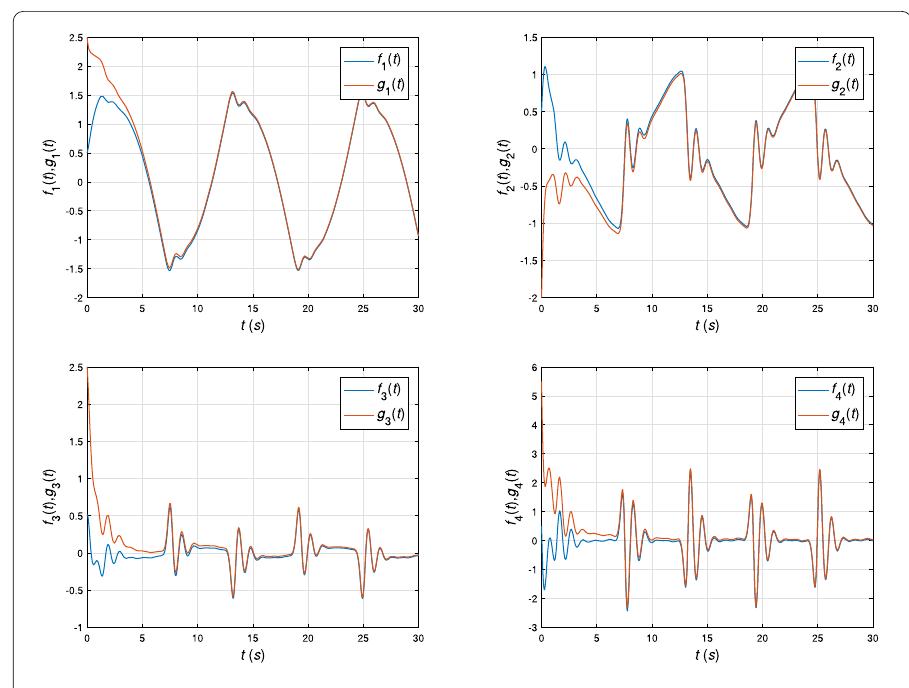
Figure 13 The state trajectories of the synchronized systems (19) and (20) for q = 0.9